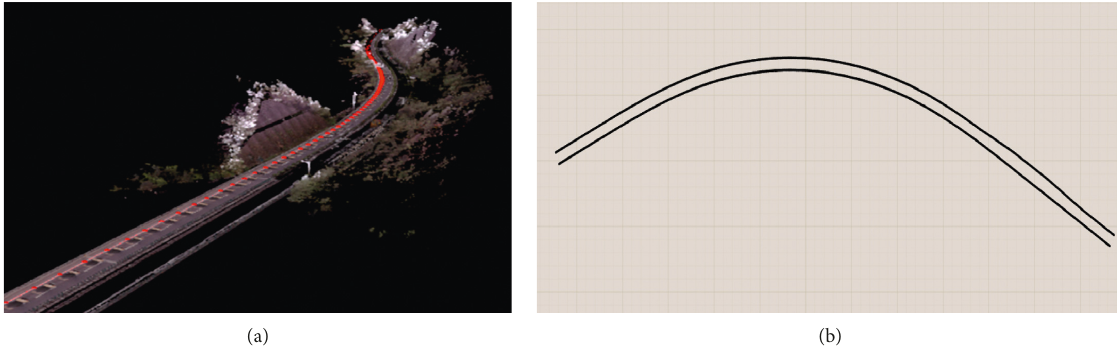
Figure 2: Extraction of landmarkings from point cloud.